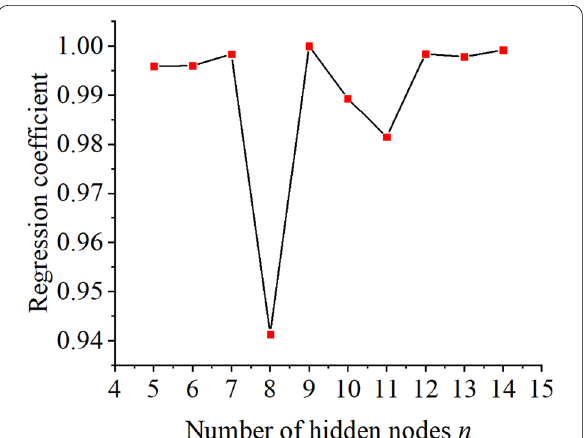
Figure 9 Relationship between hidden nodes and regression coefficients